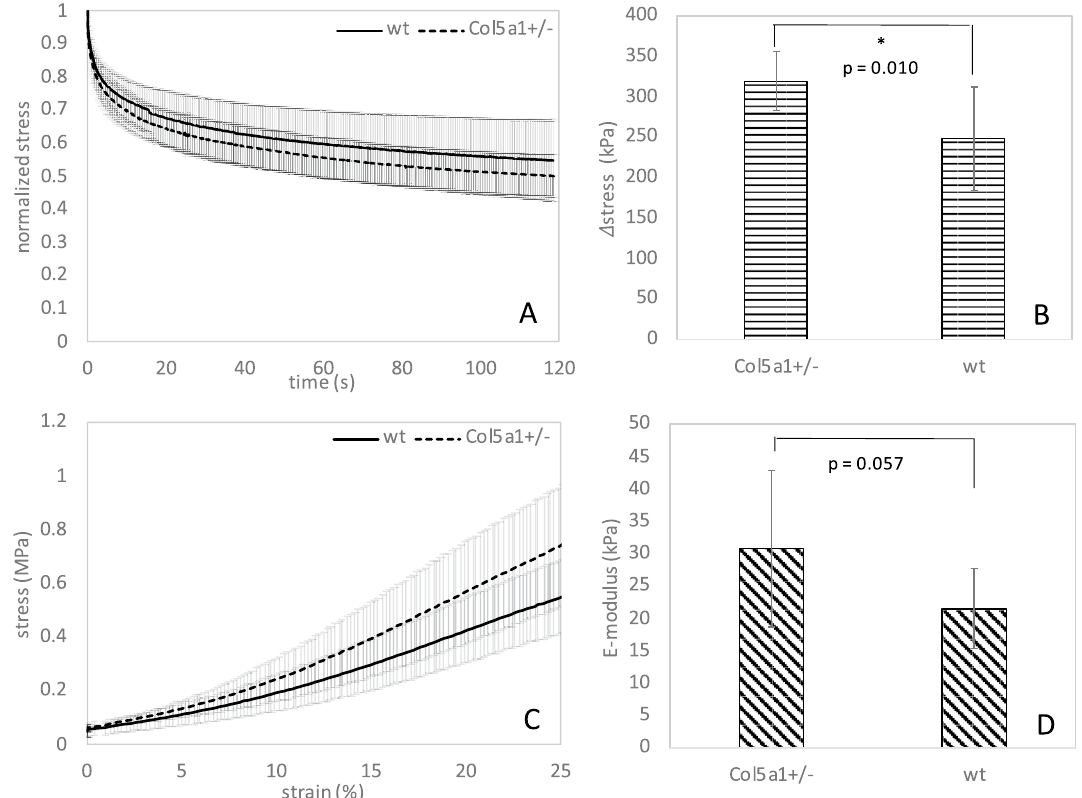
Figure 3. ( A ) Stress-relaxation curve (n = 12, Col5a1 +/− and n = 14, wt), ( B ) absolute stress reduction after relaxation (n = 12, Col5a1 +/− and n = 14, wt), ( C ) stress–strain curve (n = 8, Col5a1 +/− and n = 11, wt) and ( D ) average E-modulus between 10 and 15% of strain (n = 8, Col5a1 +/− and n = 11, wt) for wild-type and Col5a1 +/− corneas. * indicates statistical significance at p <